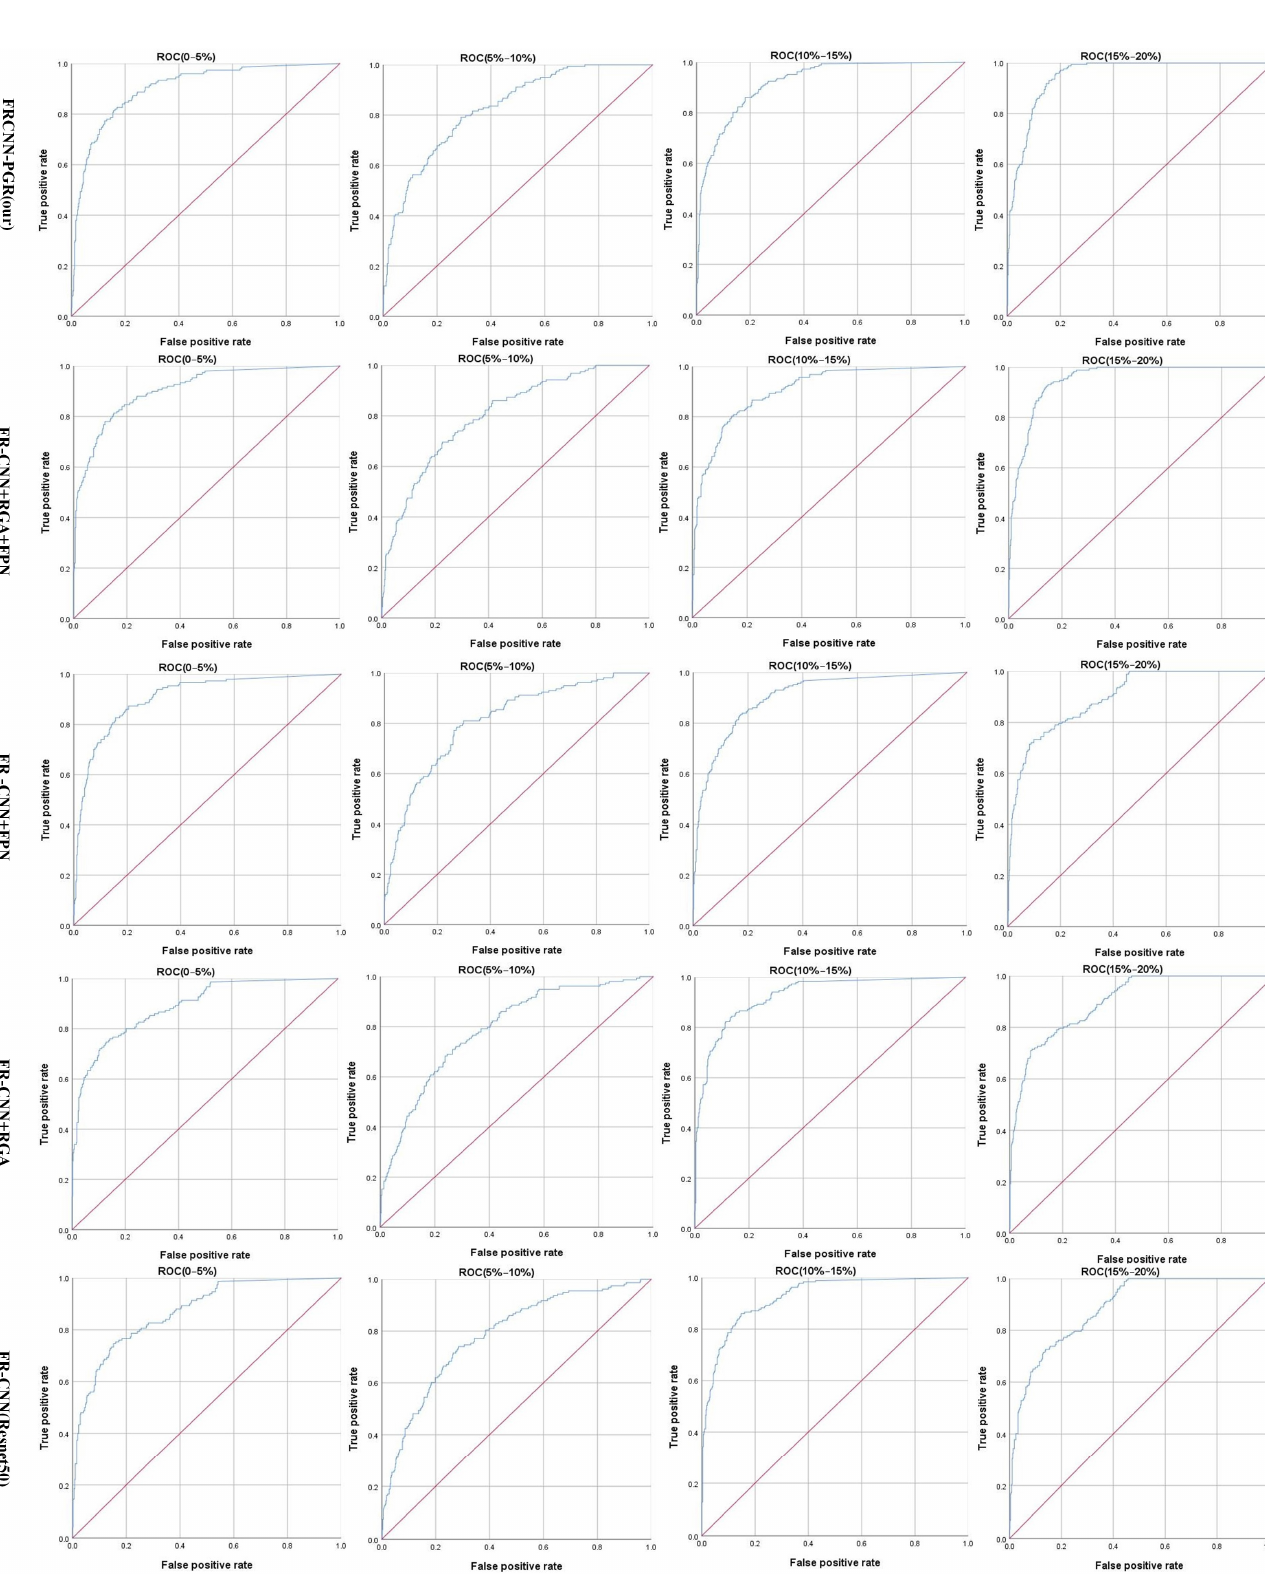
Figure 15. The ROC curves of di ff erent